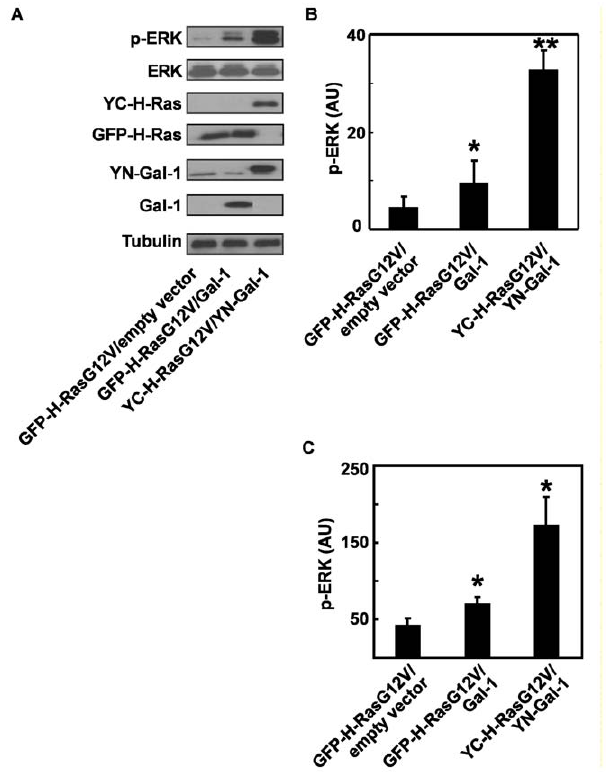
Figure 4. Enhanced activation of ERK by YC-H-RasG12V˜ YN-Gal- 1 complexes. HEK 293 or BHK cells were co-transfected with GFP-H- RasG12V/empty vector, GFP-H-RasG12V/Gal-1 or YC-H-RasG12V/YN-Gal- 1 and lysed 48 h later. Aliquots of the cell lysates were subjected to SDS-PAGE followed by immunoblotting with anti-phospho-ERK, anti- ERK, anti-pan-Ras, anti-Gal-1 and anti-tubulin (loading control) antibod- ies. Typical immunoblots representing one of four experiments performed with HEK 293 cell are shown in panel A and quantitative densitometry of the levels of phospho-ERK (arbitrary units, means 6 SEM, n=4) are shown in panel B. * P , 0.05, GFP-H-RasG12V/Gal-1 vs. GFP-H-RasG12V/empty vector; ** P , 0.0001, YC-H-RasG12V/YN-Gal-1 vs. GFP-H-RasG12V/Gal-1. Results obtained with BHK cells (arbitrary units, mean 6 SEM, n=2, * P , 0.05) are shown in panel C.